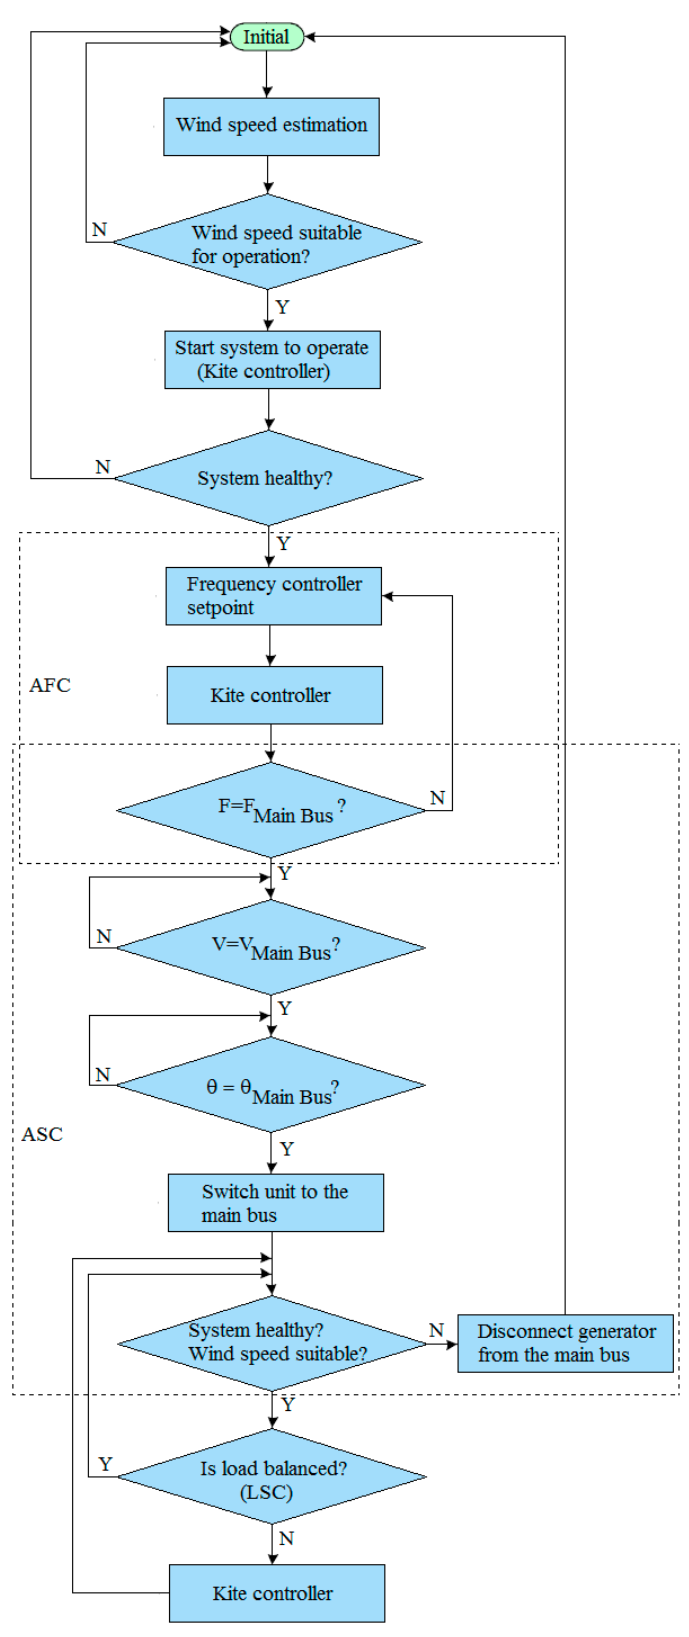
Figure 4. Direct interconnection algorithm.